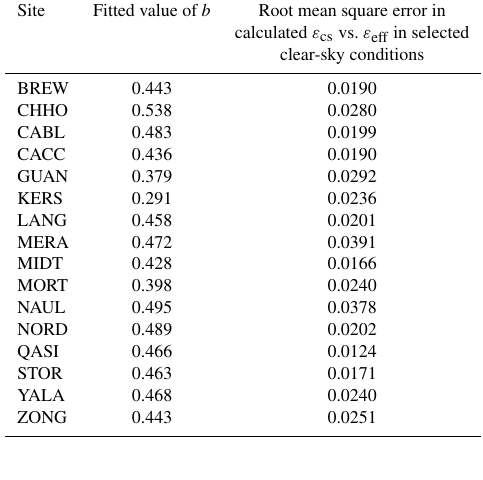
Table A1. Optimised clear-sky emissivity coefficients and error in ε cs .